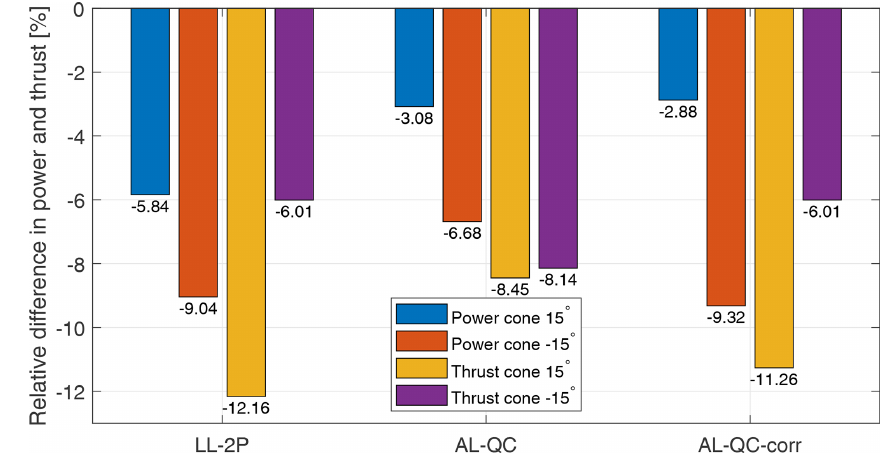
Figure 21. The relative difference in thrust and power of the rotor with 15 ◦ upwind- and downwind-coned straight blade aligned to the quarter-chord line compared to the rotor with the same straight blade without coning predicted by the LL-2P method, the AL method without the correction (AL-QC) and the AL method with the correction